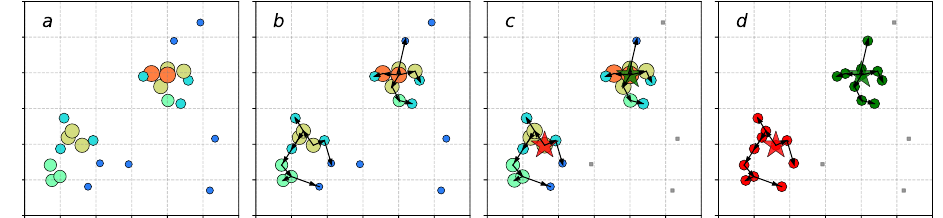
Figure 2. Demonstration of CLUE procedure [7].